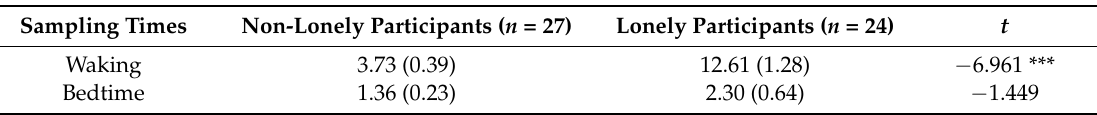
Table 4. Means ( SEMs ) of Cortisol Concentrations (nmol/L) in Lonely vs. Non-Lonely Participants at Waking and Bedtime. *** p <